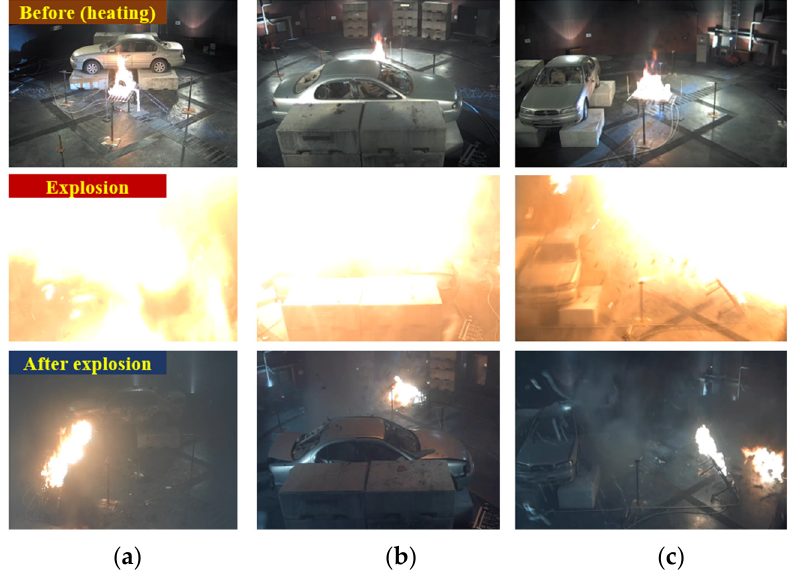
Figure 5. Scenes of the hydrogen tank explosion test in each direction: ( a ) left side; ( b ) right side; ( c ) front side.